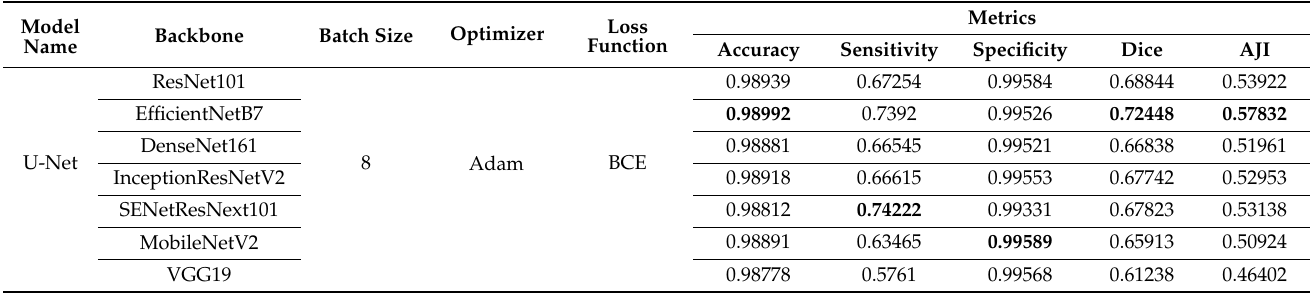
Table 2. Comparative results of U-Net with the different backbones and the batch size of 8 (bold represent the best